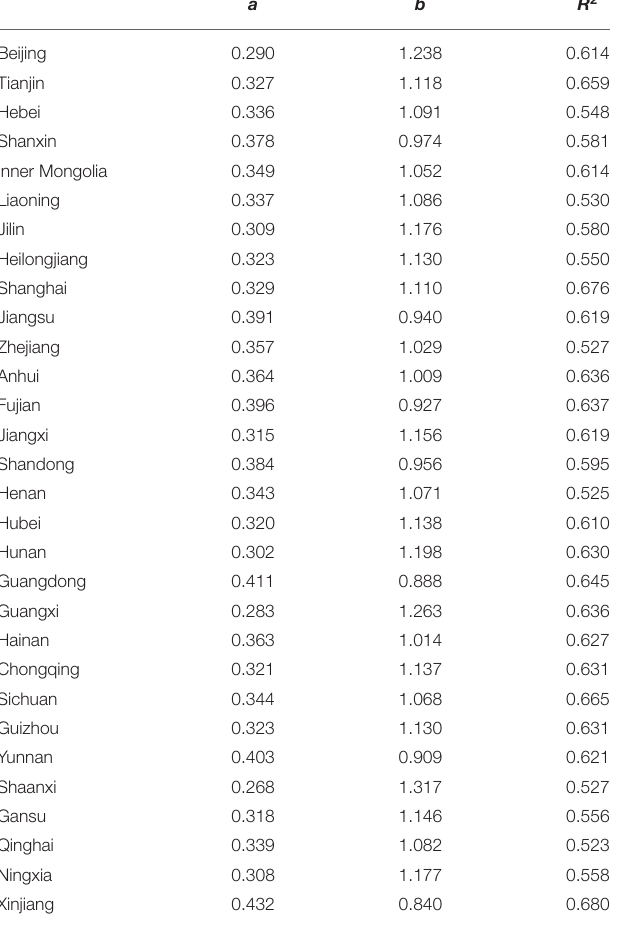
TABLE 3 | The fitting parameters ax − b and goodness of fit R 2 of degree distribution of 30 provinces.